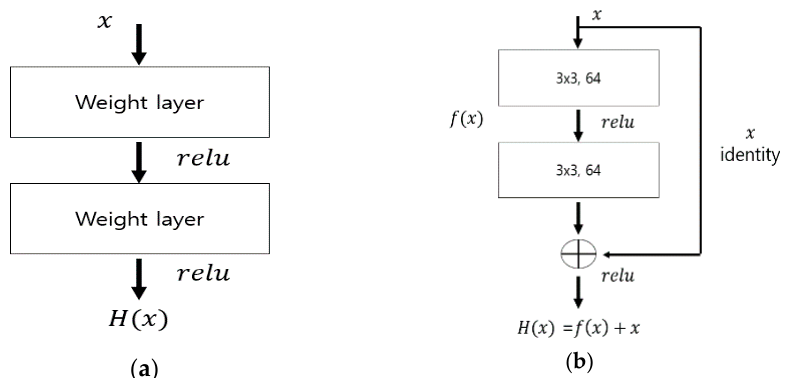
Figure 6. Structures of ( a ) the plain block; ( b ) the residual block [12,17].